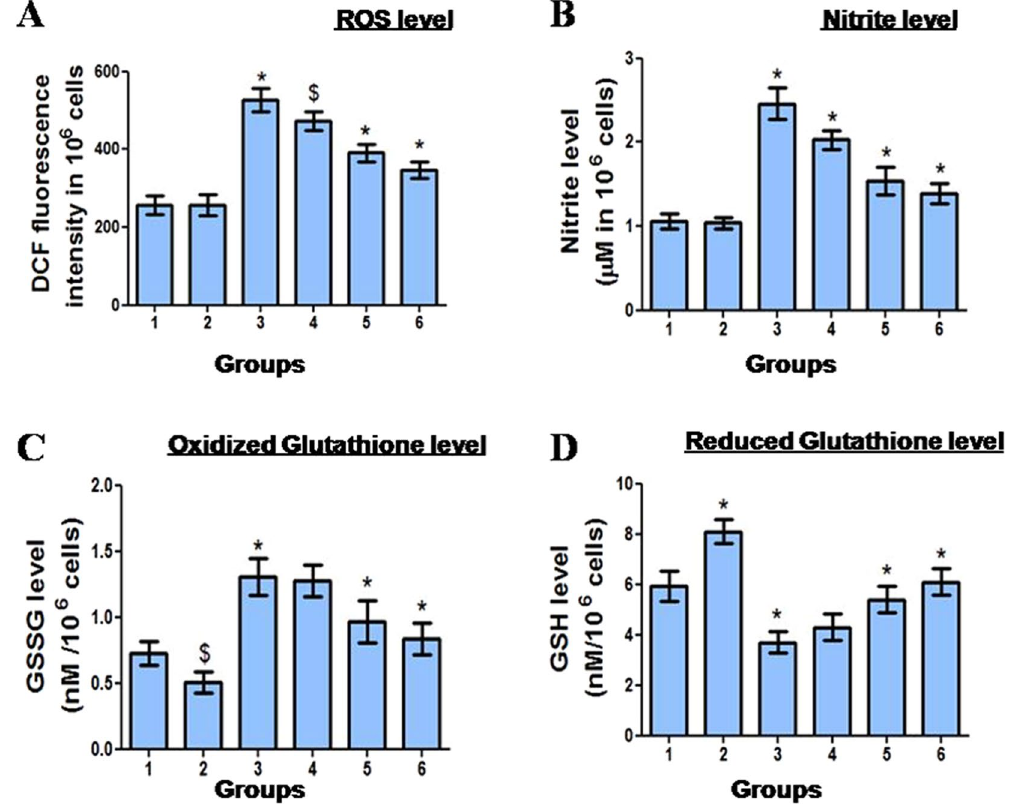
Figure 3. Modulation of CBDCA-induced redox imbalance by MUS in murine bone marrow cells. MUS reduced the levels of ( A ) ROS, (B) NO, (C) GSSG and enhanced the level of (D) GSH in bone marrow cells. Data are represented as mean ± SD, n = 6. * Denotes (P < 0.001) and $ denotes (P < 0.05) as compared to their respective control